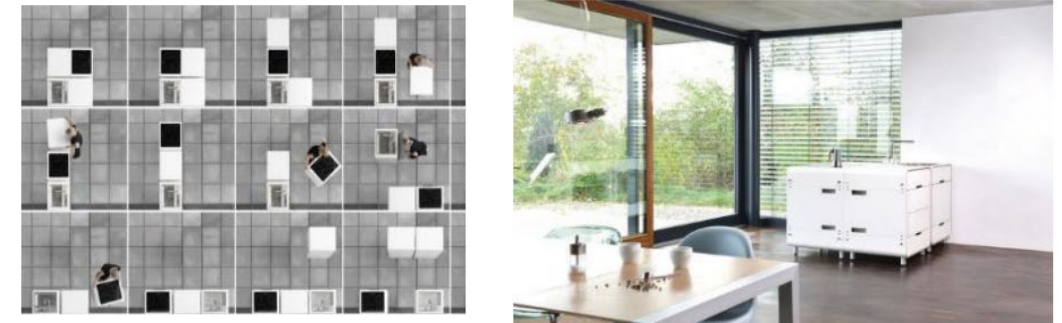
Figure 12 (left) & 13 (right) A la Carte Kitchen by Stadtnomaden (Architonic, 2014).